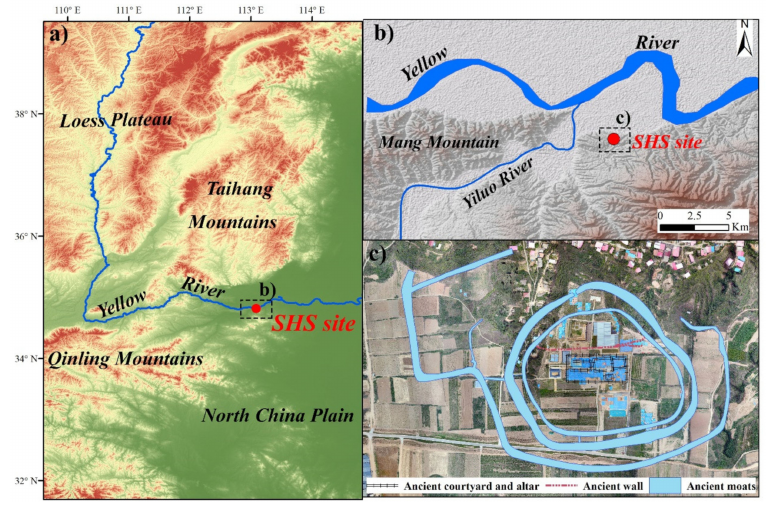
Figure 1. The geographical location of the SHS site: ( a ) the site is located in the northern central part of Henan Province, China; ( b ) the surroundings of the SHS site at a large spatial scale; ( c ) the layout of the SHS